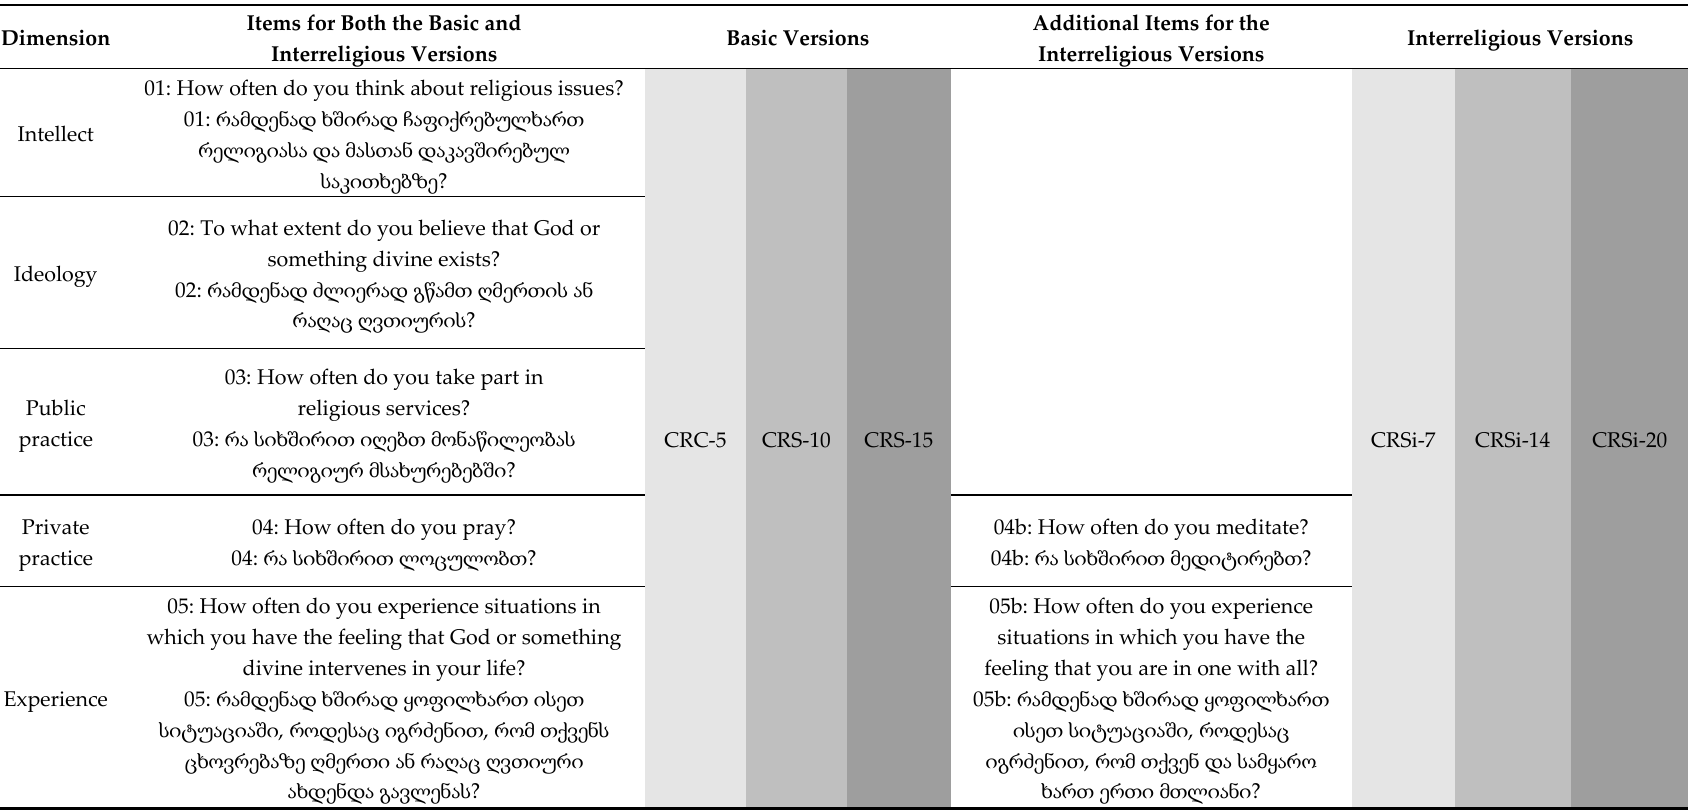
Table A1. Items of the CRS shared by the short, intermediate and long versions.